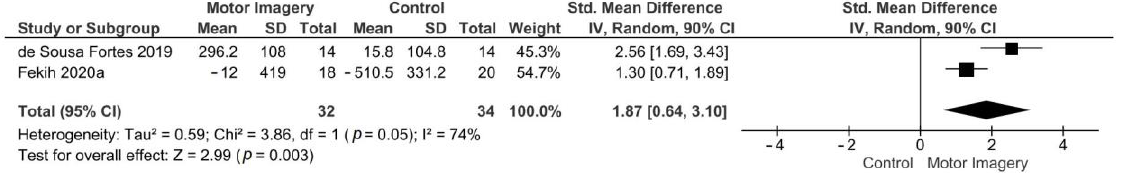
Figure 6. Effect of motor imagery training on tennis service performance versus watching videos as control